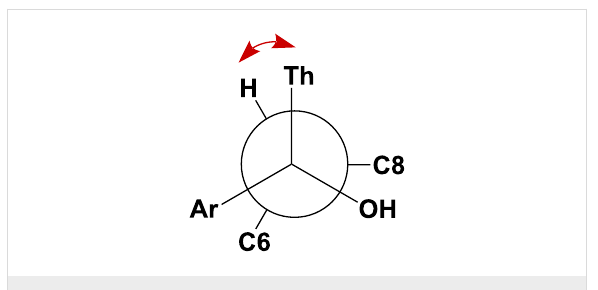
Figure 4: Diagnostic NOE interactions in compounds 4 and 5